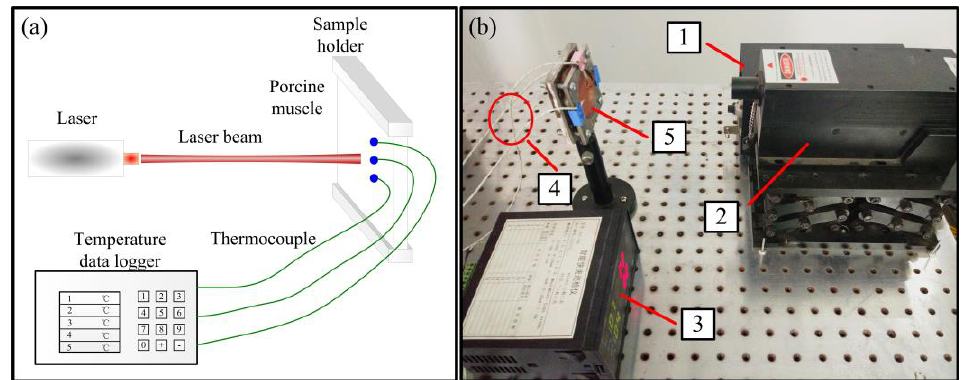
Figure 11. Laser heating experiment. ( a ) schematic diagram and ( b ) experimental system of interaction between laser and in vitro biological tissue. 1: laser controller; 2: laser; 3: temperature data logger; 4: thermocouple; 5: porcine muscle.